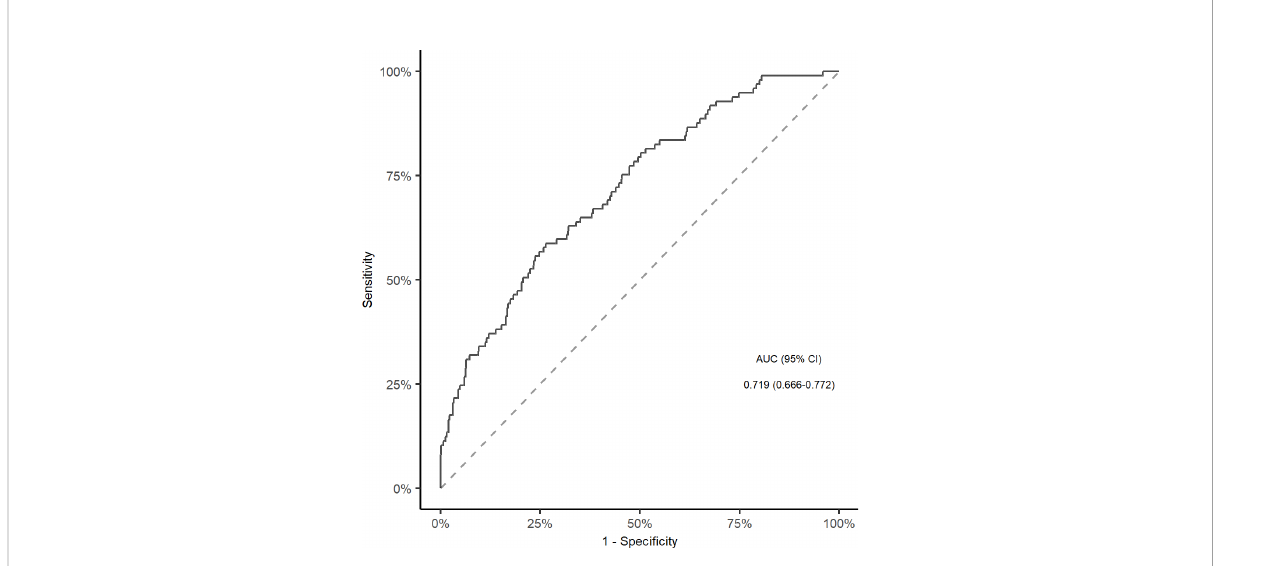
FIGURE 3 ROC curve and corresponding AUC for TyG index to predict Stroke recurrence in elderly patients. ROC, receiver operative characteristic; AUC, area under the curve; TyG, triglyceride-glucose